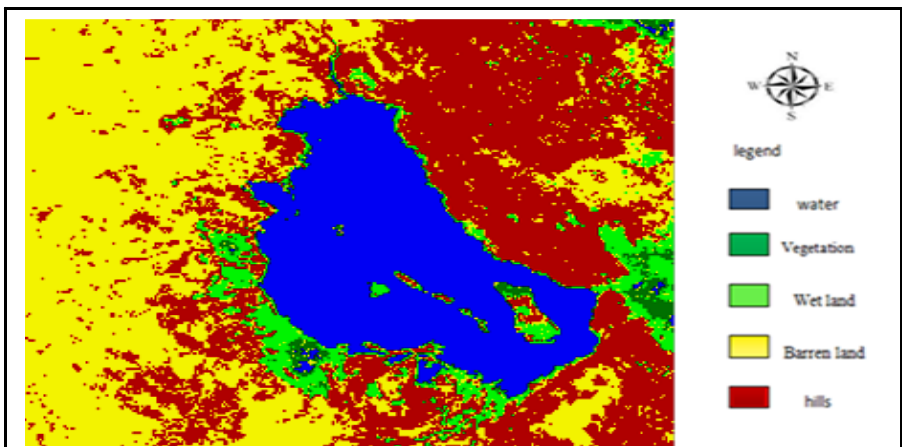
Fig.5: Unsupervised classification using mean value for Landsat-7 (1999).